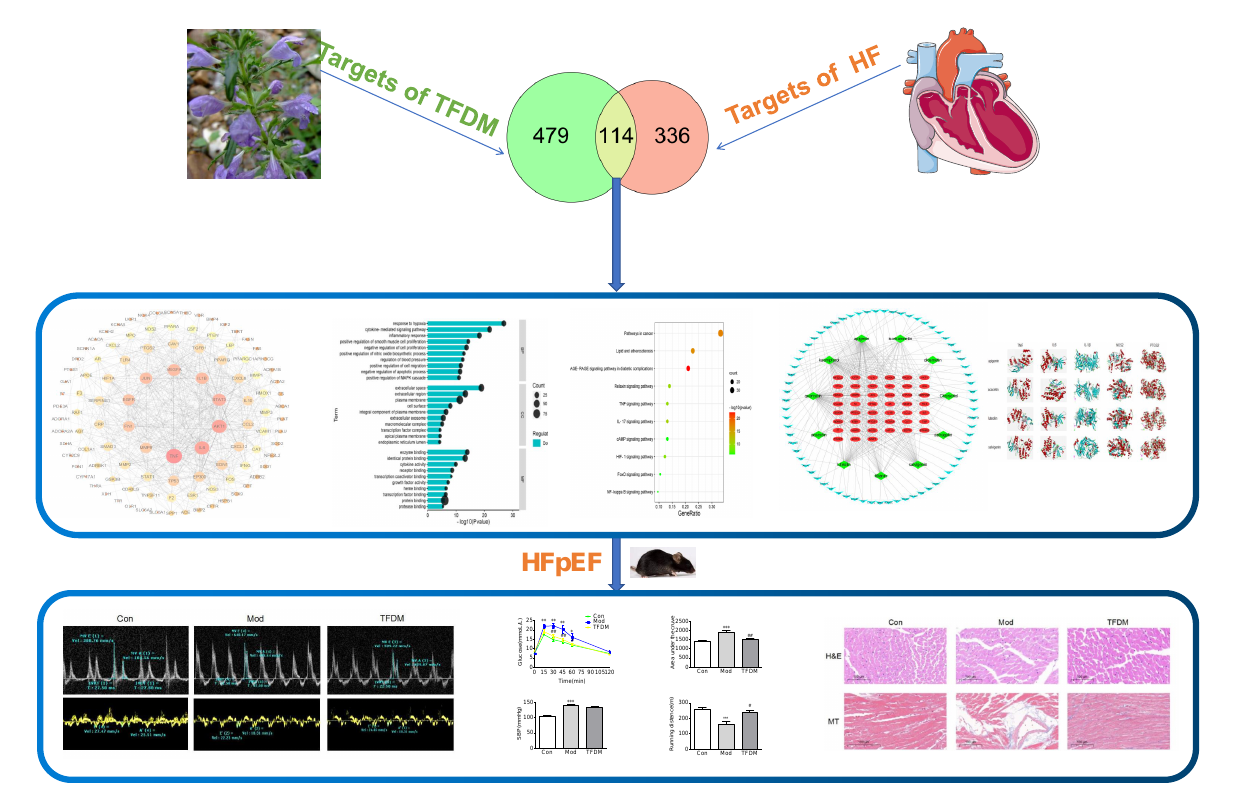
Figure 1. Workflow of the present study.